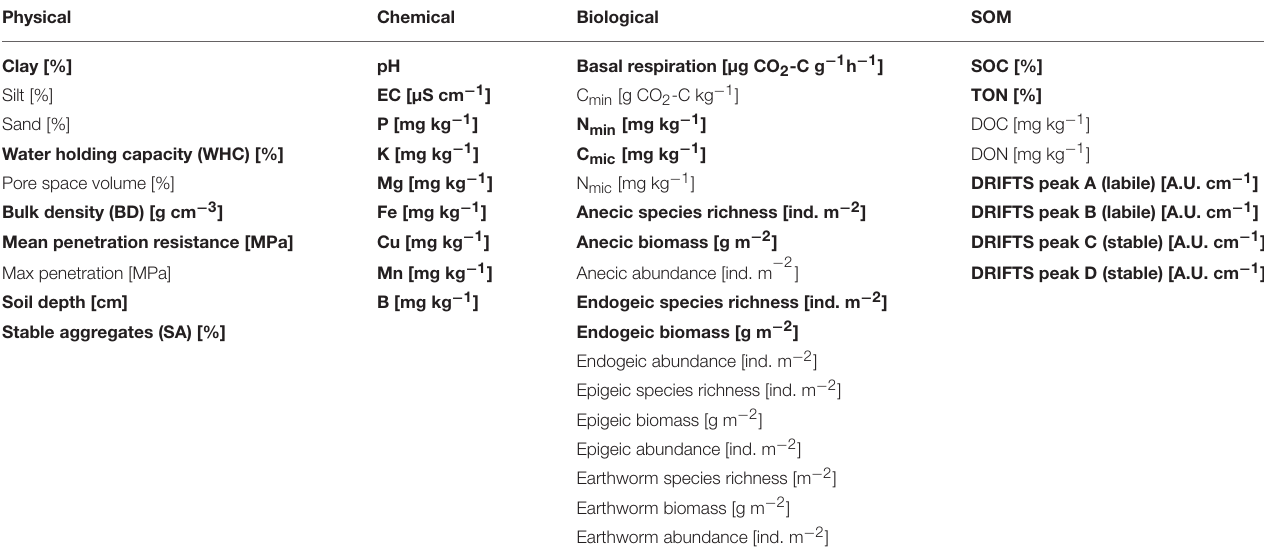
TABLE 1 | Measures of soil quality (MSQ) ( N = 44) obtained in all urban garden sites ( N = 170).